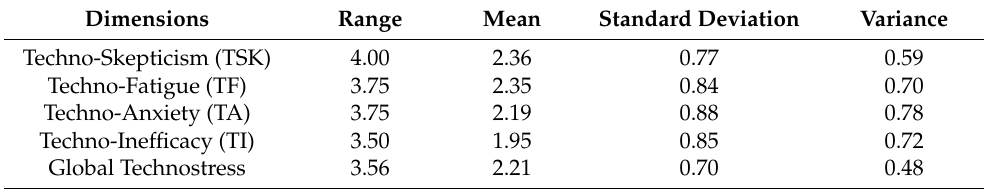
Table 2. Descriptive statistics of technostress and its dimensions.